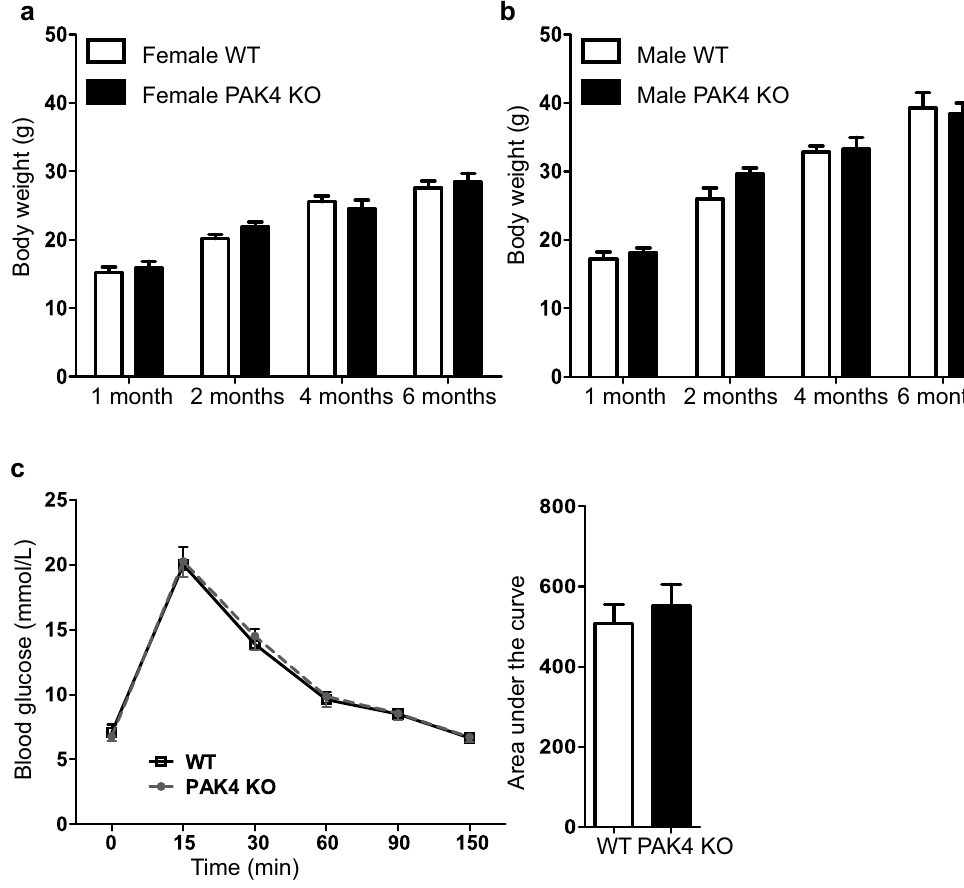
Figure 4. PAK4 KO mice have normal body weight and glucose regulatory function. ( a ) The body weight of 1, 2, 4, and 6 months old mice were from ( a ) female and ( b ) male WT and PAK4 KO groups. Results are means ± SEM. T-test revealed no discernible differences between the genotypes. 1 month-female (p = 0.5618, n = 4); 2 months-female (p = 0.0864, n = 12 (WT) and 6 (PAK4 KO)); 4 months-female (p = 0.4756, n = 9(WT) and 6 (PAK4 KO)); 6 months-female (p = 0.5589, n = 11 (WT) and 16 (PAK4 KO)); 1 month- male (p = 0.4834, n = 14); 2 months-male (p = 0.0880, n = 5–6); 4 months-male (p = 0.7804, n = 12 (WT) and 7 (PAK4 KO)) and 6 months-male (p = 0.6544, n = 4). ( c ) Glucose tolerance test in WT and PAK4 KO mice. Following 6 h of fasting, 8 weeks old female mice were injected intraperitoneally (IP) with 2 g/kg glucose. Blood glucose was measured at the indicated time points after intraperitoneal glucose injections. Data are expressed as the mean + SEM. The left graph shows the time. The right bar graph displays the area under the time curve. Data are expressed as the mean ± SEM. T-test revealed no discernible differences between the genotypes (p = 0.5428, n =